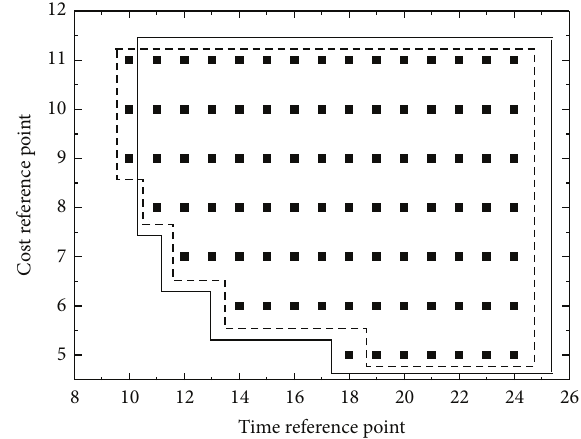
Figure 7: Possible reference points of carpooling success with detour distance 1.5 km.